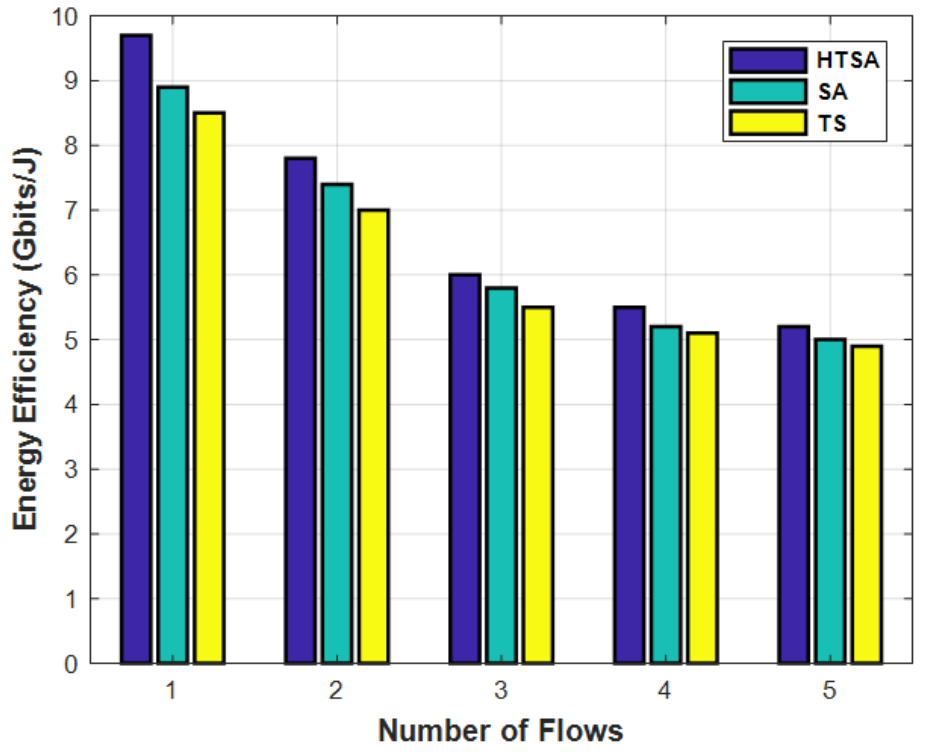
Figure 6. Energy efficiency with varying number of flows.